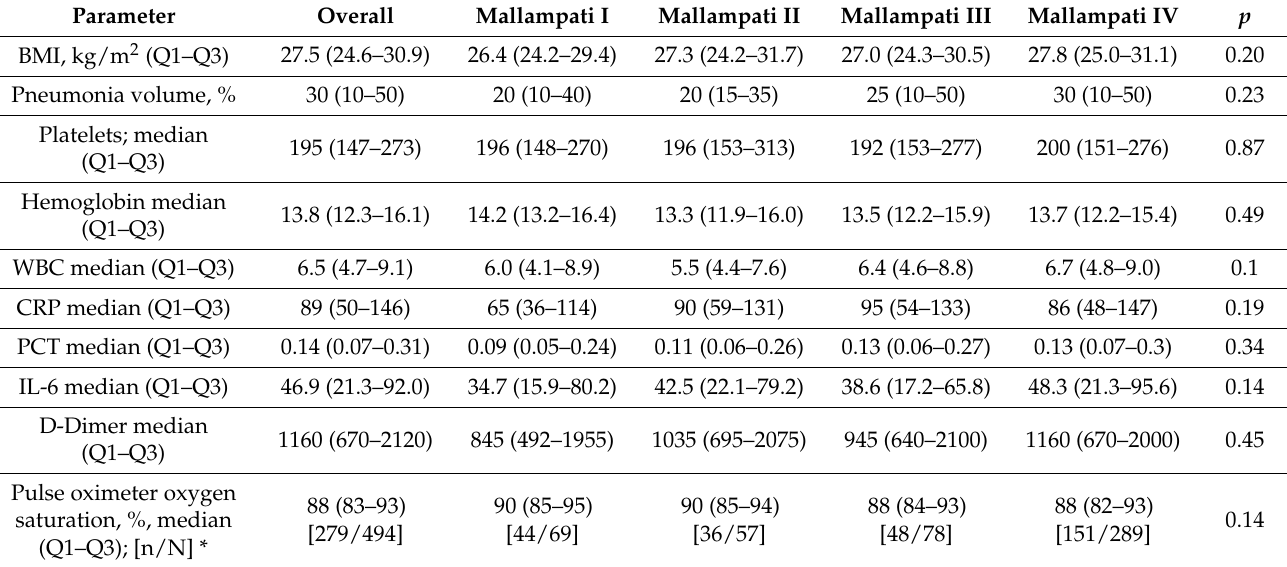
Table 2. Laboratory and imaging parameters at